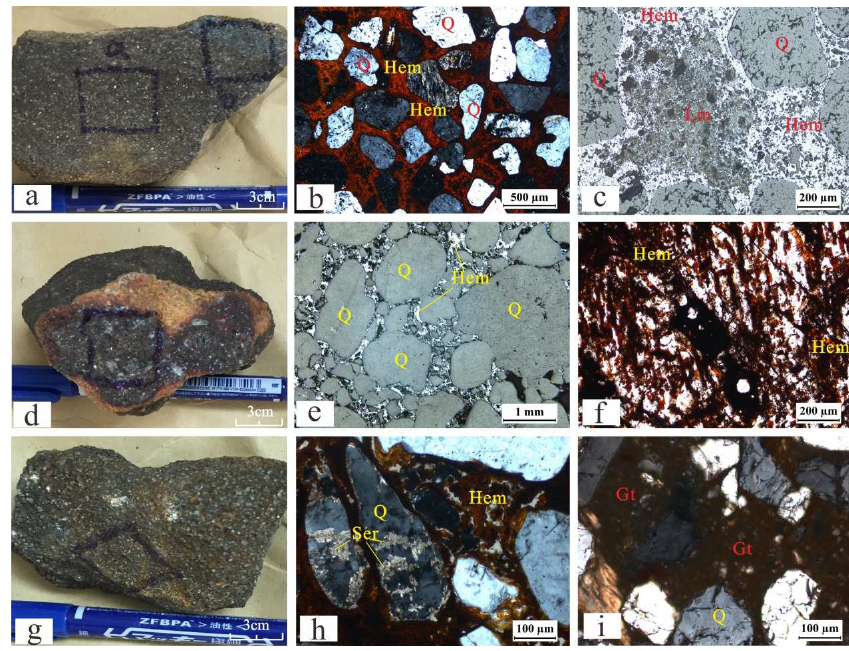
Figure 4. Ferruginous sandstone lithology and alteration features in Wajid Sandstone. ( a – c ) Y5.1/SR08: Dark grey coarse ferruginous sandstone. Ferrous cemented quartz sandstone: Quartz is the main mineral particle that contains a small amount of feldspar, hematite, and limonite filling the space between mineral particles. ( d – f ) Y5.1/SR07: Dark grey and brownish-yellow gravel-bear- ing coarse ferruginous sandstone. Quartz is the main mineral particle, with a gravel structure. Hematite primarily fills the spaces between the mineral particles and occurs in the intergranular pore and intragranular dissolved pores. ( g – i ) Y5.1/SR06: Dark grey coarse ferruginous sandstone. Hematite can be seen in the sandstone. Sericite alteration occurs on the surface of the feldspar par- ticles, and goethite fills the spaces between the mineral particles. Q—quartz; Hem—hematite; Lm—limonite; Ser—sericite; Gt—geothite.